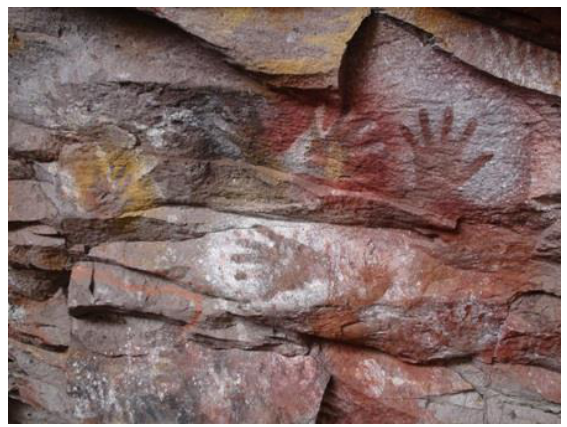
Figure 24. Charcamata, Santa Cruz, Argentina.